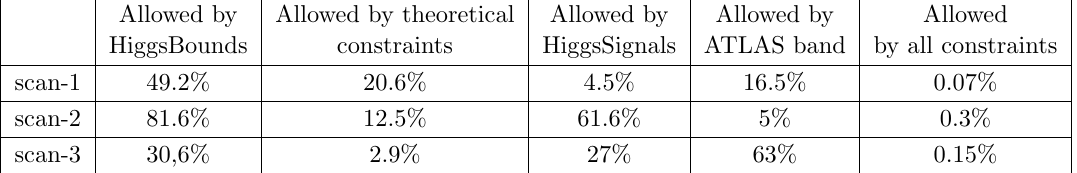
Table 4. Parameters as in table 3 with 10 6 points as inputs for all